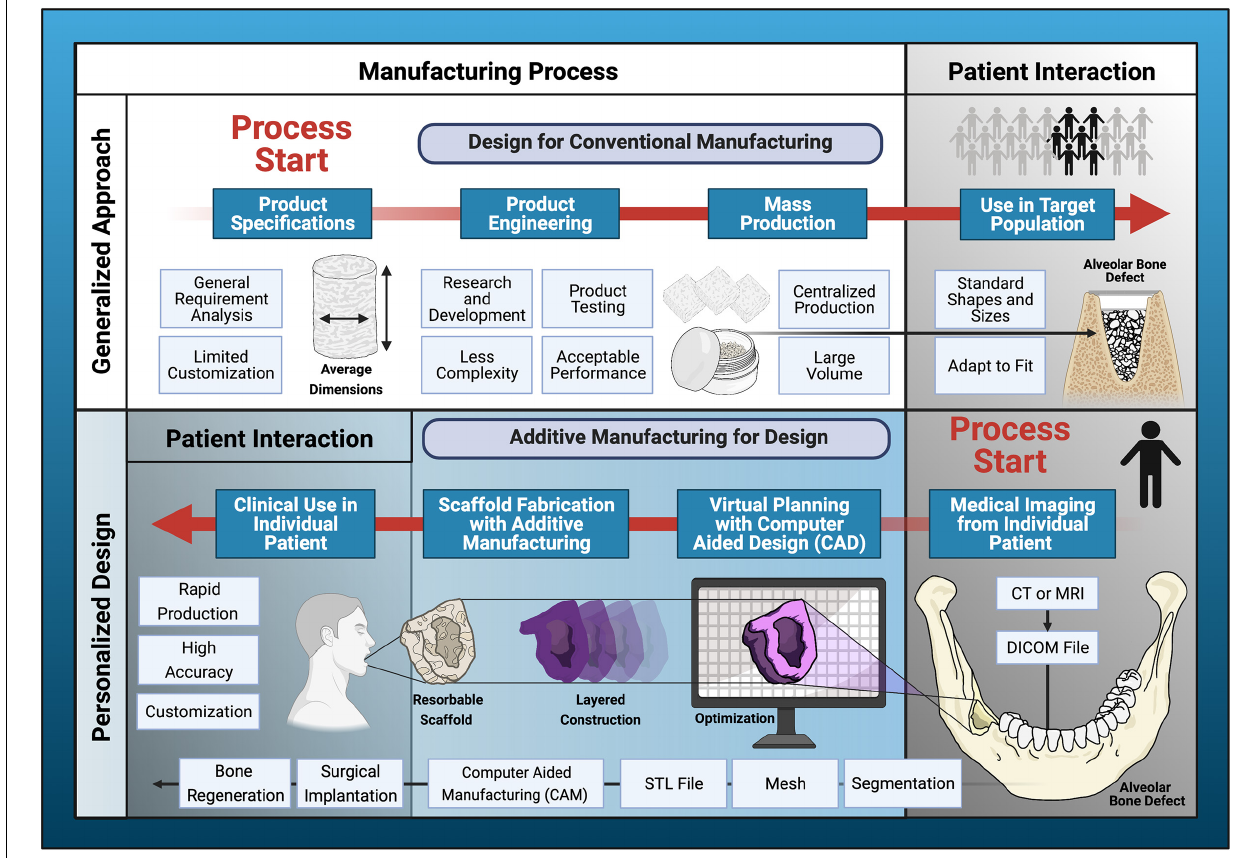
FIGURE 3 | Paradigm shift in scaffold production. Additive manufacturing has introduced a departure from design for conventional manufacturing processes to additive manufacturing driven by design for the individual patient. The generalized design approach utilizes traditional product specification and engineering processes to facilitate large-scale production for distribution to a target population. Disadvantages of conventional manufacturing include limited capacity for complex designs and less customization. Additive manufacturing (AM) utilizes individual patient data processed by computer-aided design (CAD)/computer-aided manufacturing (CAM) software to perform virtual planning, design optimization, and fabrication of highly personalized scaffolds for bone regeneration. This design process begins and ends with direct patient interaction. AM has enormous potential to improve accessibility to personalized regenerative medicine in everyday clinical